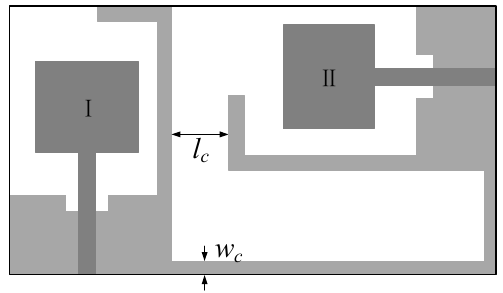
Figure 8. Compact UWB MIMO antenna: geometry [19].